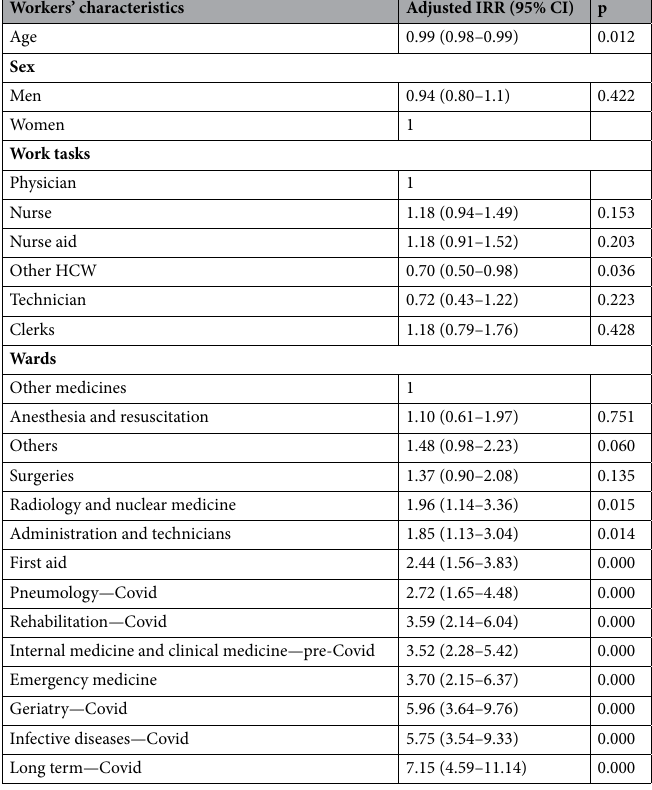
Table 3. Incidence risk ratio (IRR) and 95 confidence intervals (CI) of factors associated with COVID-19 infection in hospitals’ workers calculated using the Poisson regression adjusted for age and number of PCR test performed.